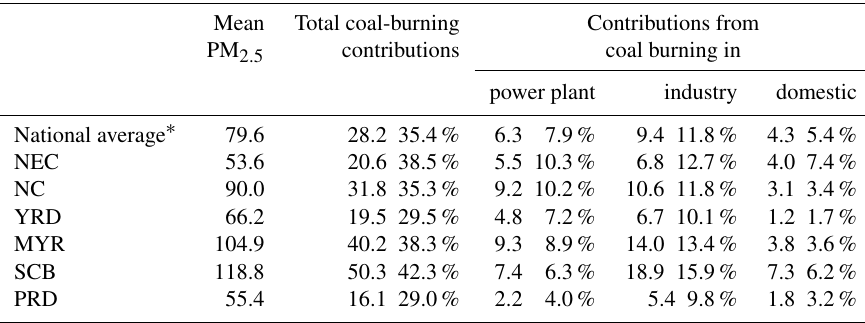
Table 4. Seasonal absolute contributions (µgm − 3 ) and percentage contributions from coal burning in winter. Mean